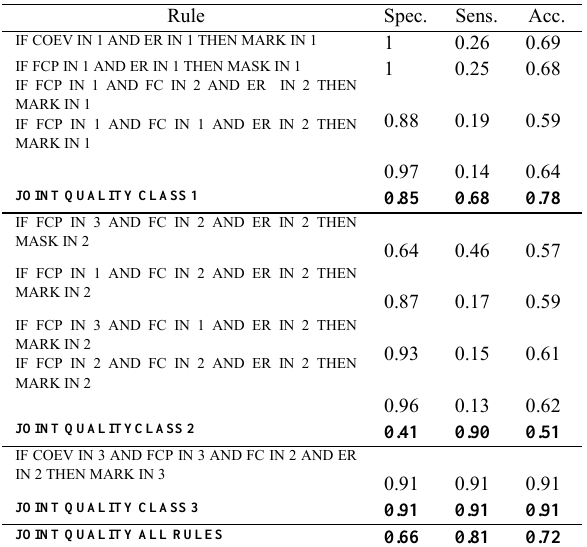
Table 14. Linguistic rules FIR model and its metrics (fuzzification parameters defined by the GA). Rule Spec. Sens.